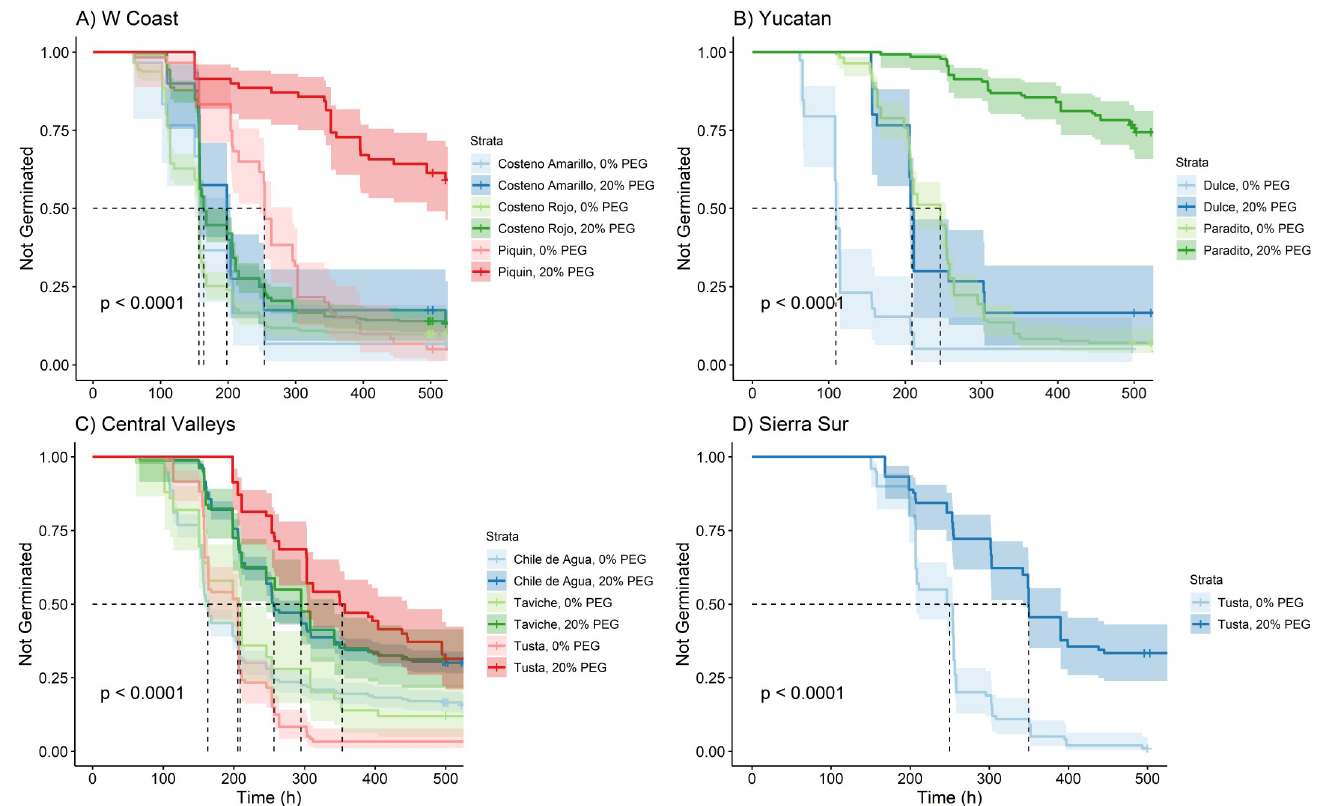
Fig 4. Kaplan-Meier estimates of survivor functions (and their 95% confidence intervals) for chile pepper originating from each ecozone in southern Mexico. (A) Western Coast; (B) Yucatan; (C) Central Valleys; (D) Sierra Sur. The p-value from a log-rank test compares survival distributions. The dotted line represents the time to 50% germination (t 50 ). Pairwise comparisons of individual curves are presented in Tables 5–8 in S3 File.